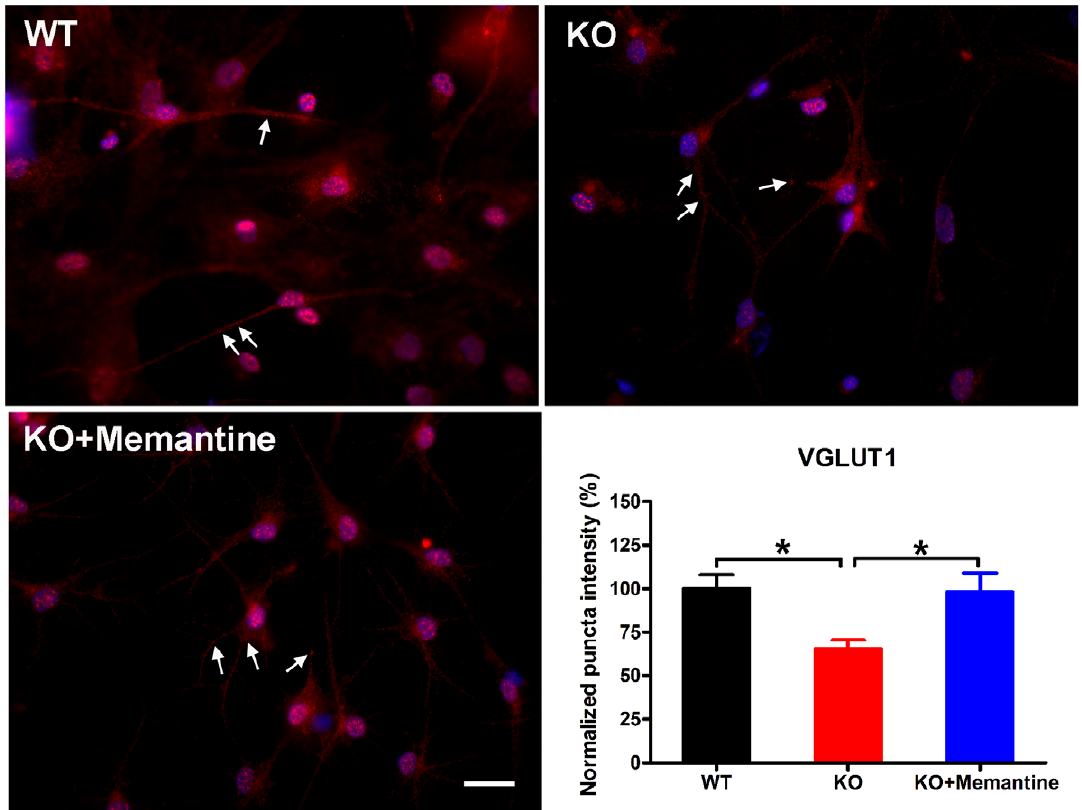
Figure 5. Memantine fully restored the intensity of excitatory synapses to a normal range in Fmr1 -KO CGCs. Representative photomicrographs of labeling of VGLUT1 (arrow) in WT CGCs, Fmr1 -KO CGCs and Fmr1 -KO CGCs treated with memantine. Red, VGLUT1; Blue, Hoechst, scale bars, 25 m m. The histogram shows quantification of puncta size using image analysis. WT, n=23; Fmr1 -KO, n=25; Fmr1 - KO + Memantine, n=26. * p , 0.05. (Figure 5, Fisher’s PLSD, p = 0.01) and fully restored the intensity of excitatory synapse to the level observed in WT CGCs (Figure 5).